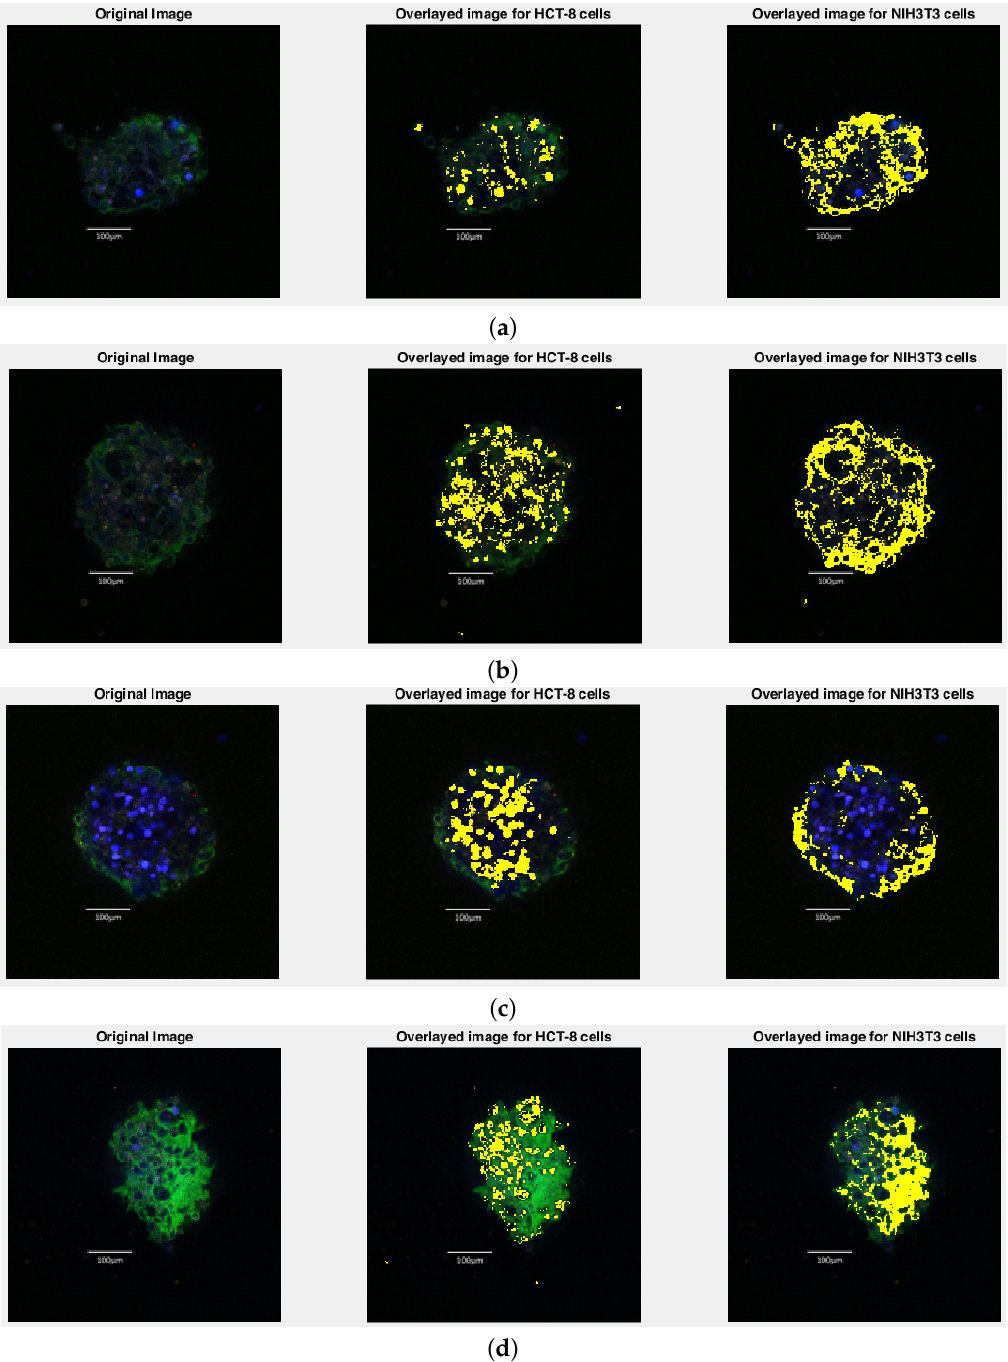
Figure 8. Overlain cluster and original images for HCT-8 and NIH3T3 cells: ( a ) 2:0.5 (2_05_ z 12), ( b ) 2:1 (2_1_ z 14), ( c ) 2:2 (2_2_ z 17), and ( d ) 2:4 (2_4_ z 10) ratio